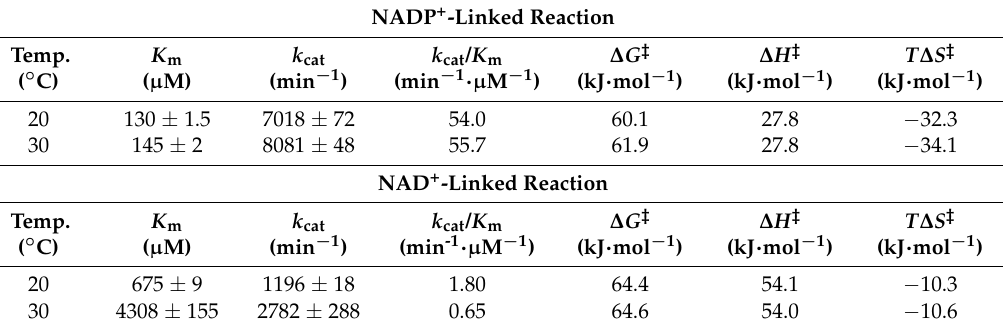
Table 3. Kinetic and thermodynamic parameters of SpG6PD1. NADP + -Linked